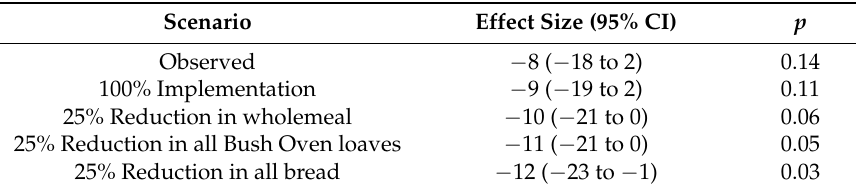
Table 3. Simulated effect size for sodium density (mg Na/MJ energy) if sodium reduction were applied to a wider range of breads.